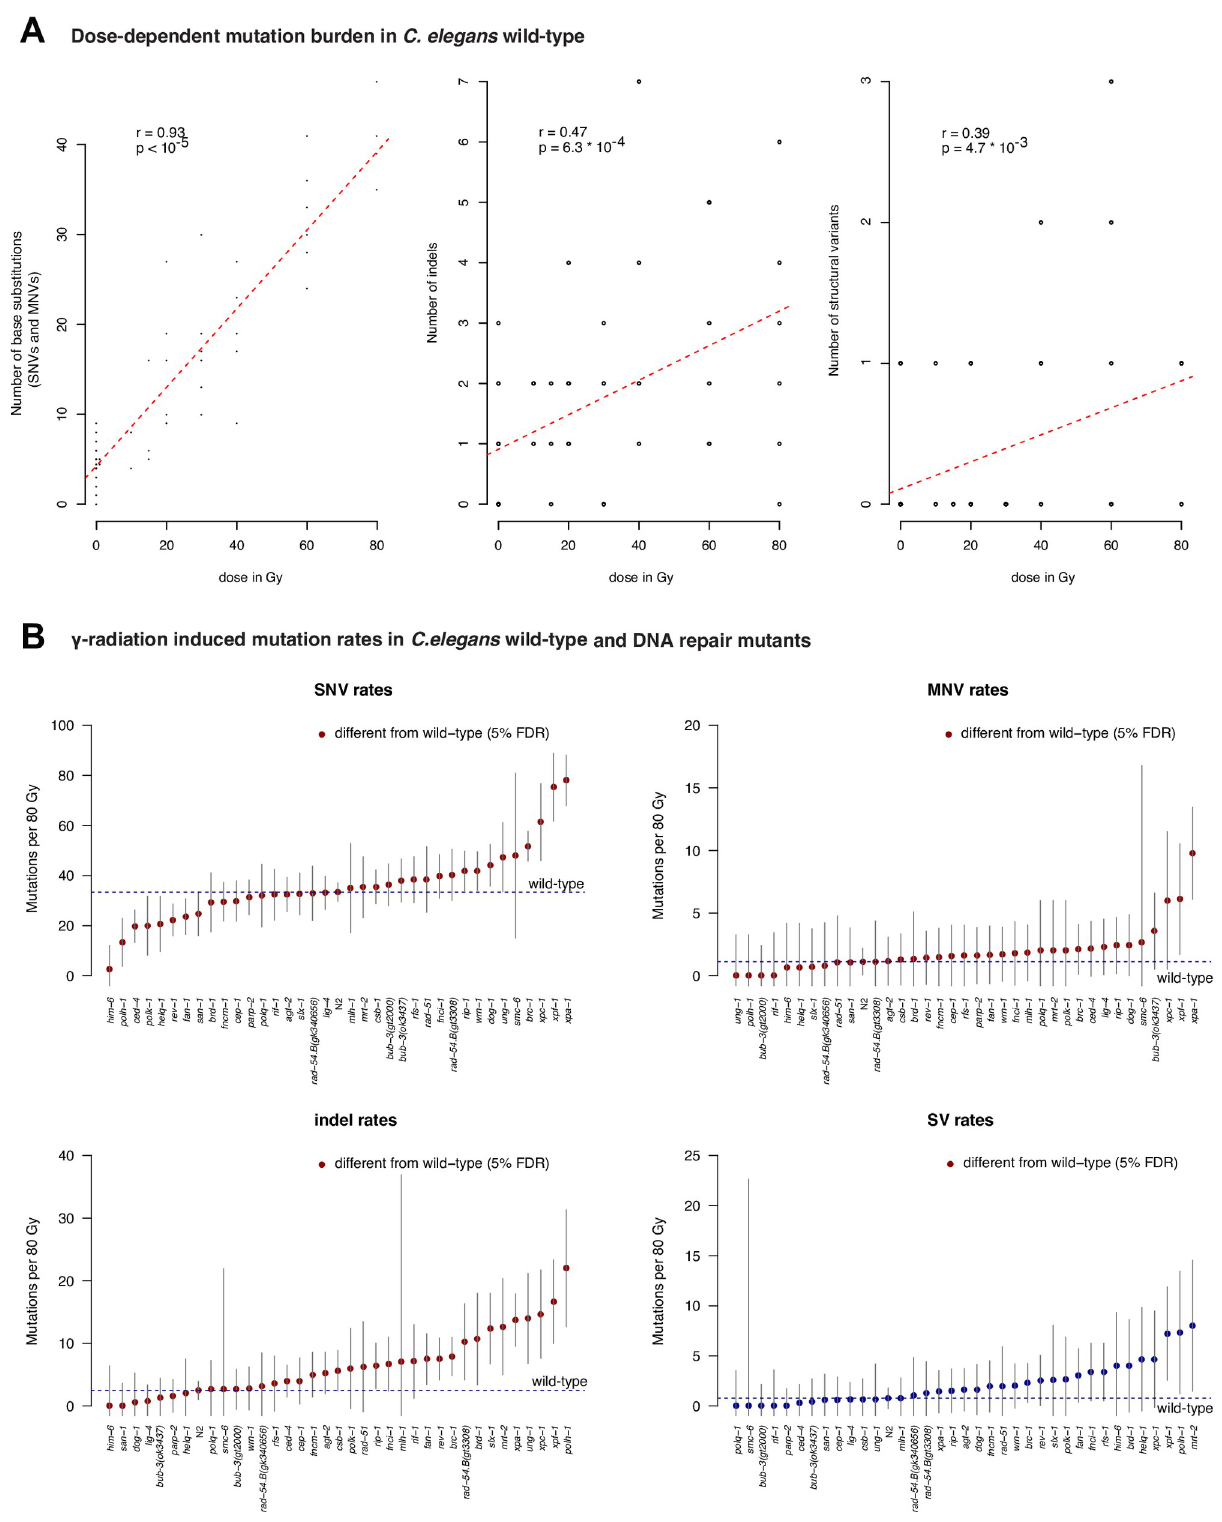
Fig 2. Dose dependent mutation burden in wild-type and DNA repair mutants. A. Number of mutations observed across Cs-137-irradiated wild- type samples by dose and mutation type; single (SNVs) and multi- nucleotide variants (MNVs) (left panel), indels (center panel) and structural variants (left panel). Black dots represent mutations observed in individual samples at a given dose, red lines represent a best fit linear regression. The values of r